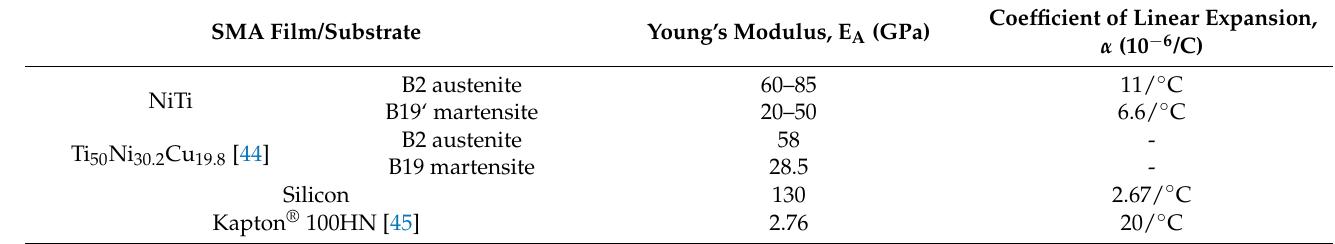
Table 1. Selected thermal and mechanical properties used in the model for the actuation study.